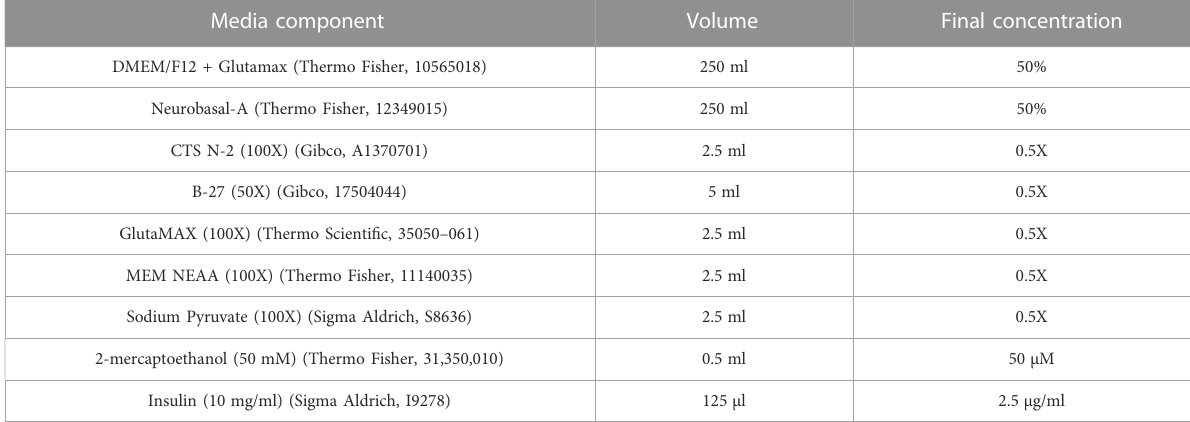
TABLE 3 Components of neural maintenance